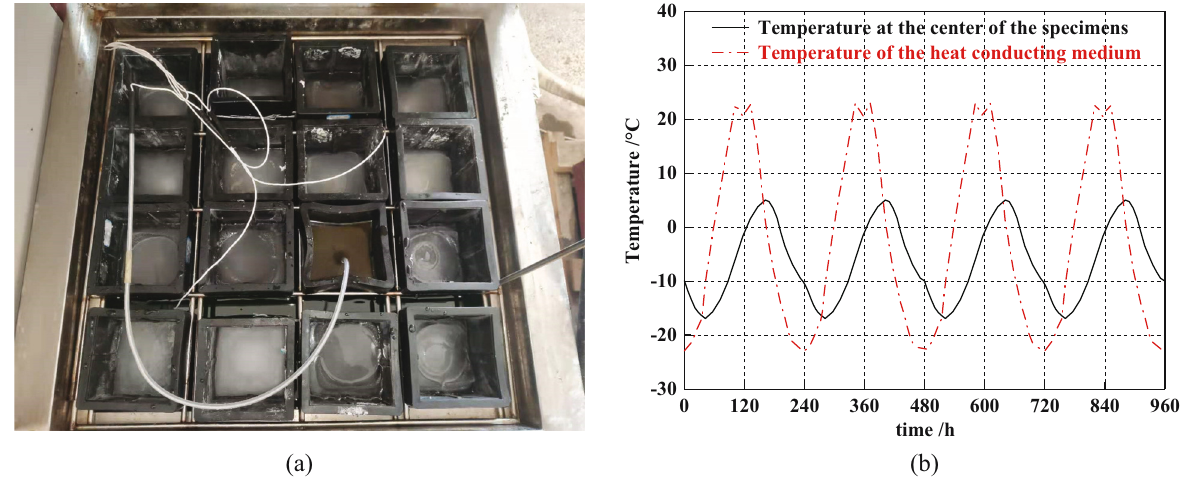
Figure 3: Working diagram of concrete rapid freeze – thaw testing machine: ( a ) internal arrangement of the freeze – thaw machine; ( b ) temperature control curve of the freeze – thaw